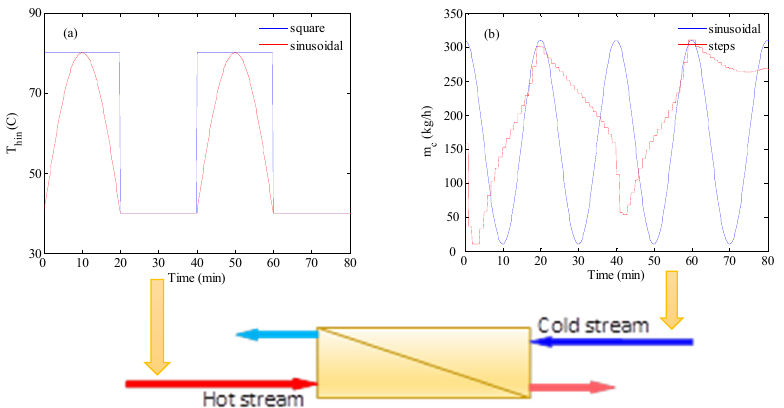
Figure 2. Input signals applied to MD; ( a ) hot feed temperature variation with solar energy; ( b ) inlet cold flow rate regulated via control system.